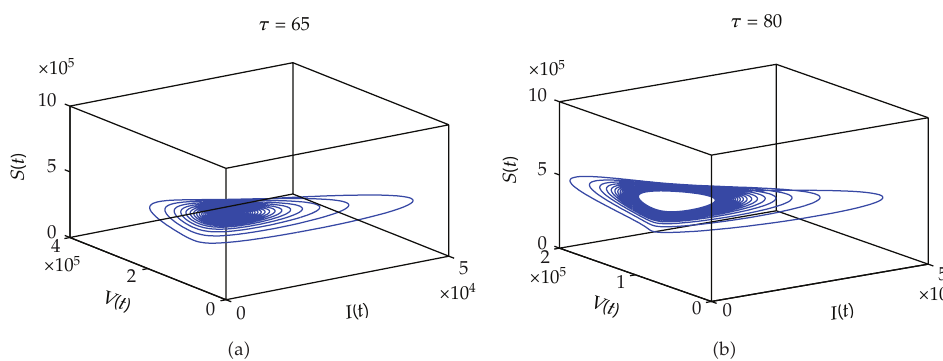
Figure 7: The projection of the phase portrait of system (cid:5) 2.1 (cid:6) in (cid:5) S,I,V (cid:6) -space.